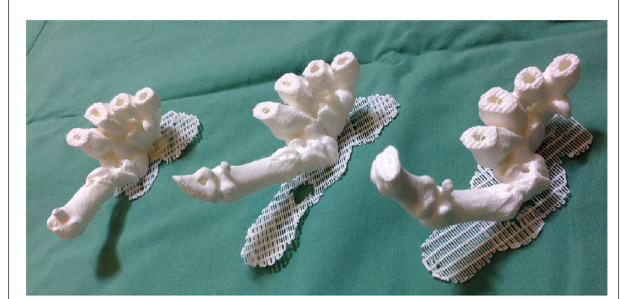
FiGURe 8 | 4D-printed haptic models of carpal and metacarpal bones demonstrating thumb abduction (from left to right) . Reproduced with permission from Journal of Reconstructive Microsurgery